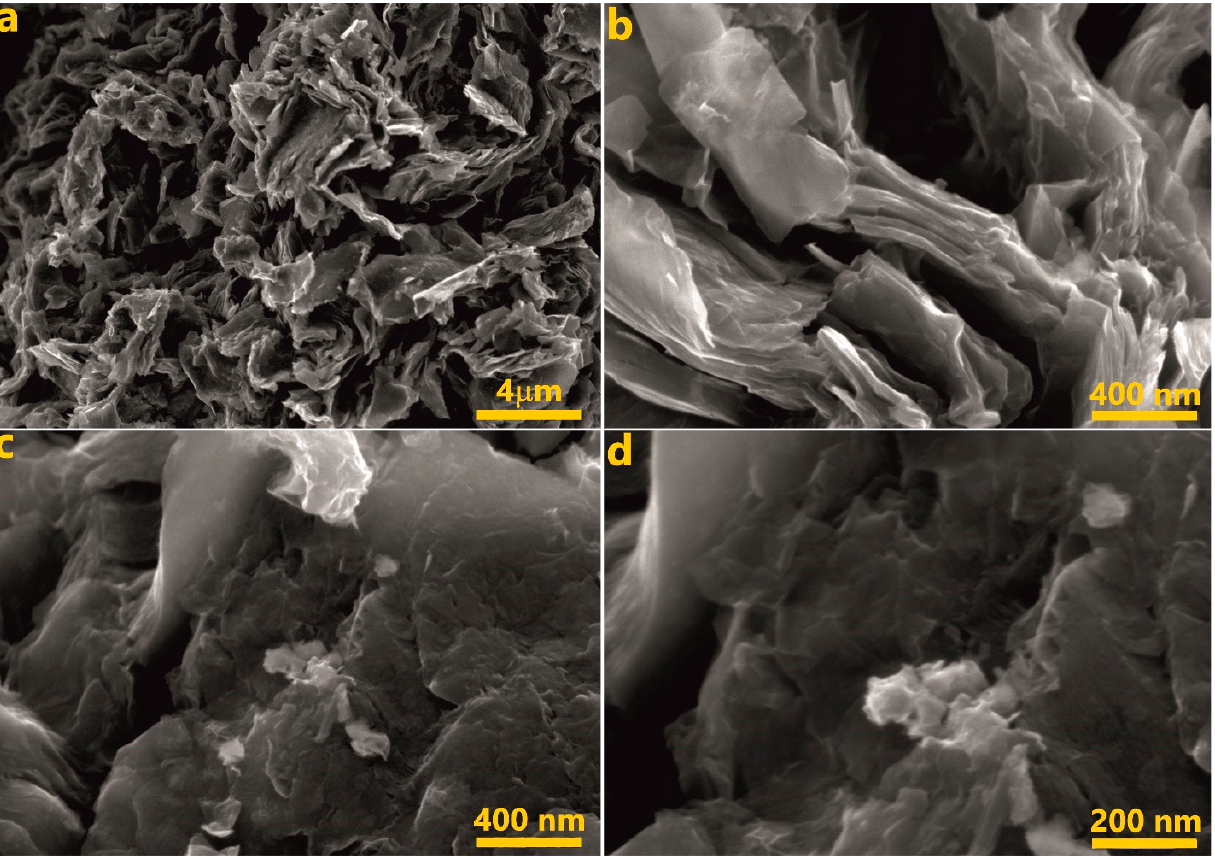
Figure 2. SEM images of r OMC/Ni, acquired at different magnifications: ( a ) low magnification image; ( b – d ) higher magnification images.